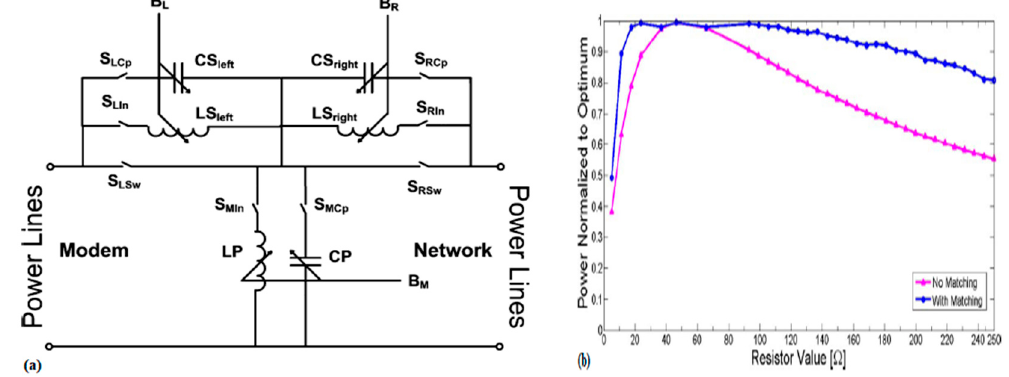
Figure 5. ( a ) Circuit structure of the L-shaped adaptive matching networks [78]; ( b ) active power transferred into the network for the system with and without matching [78].